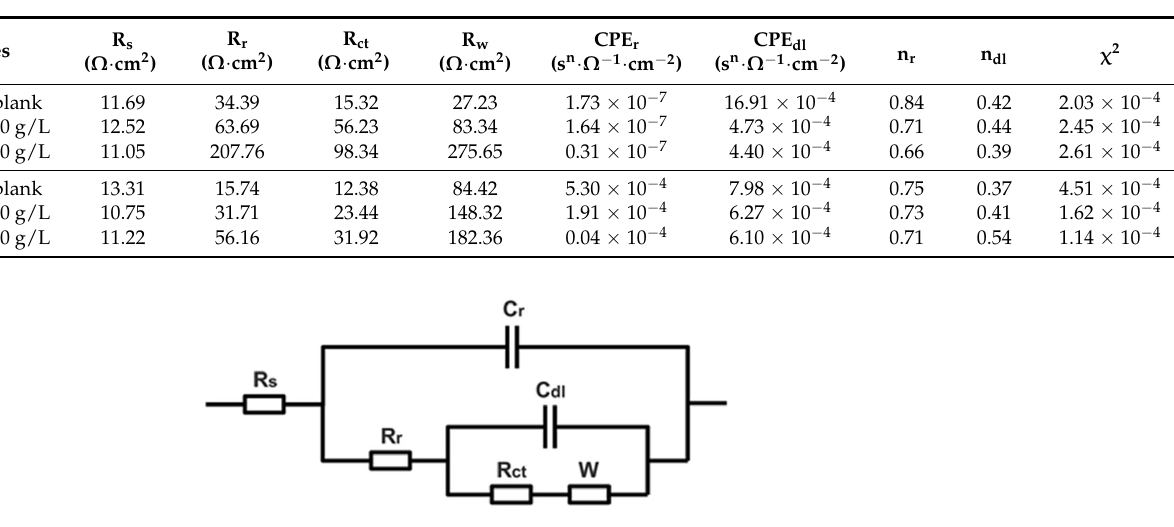
Figure 16. Equivalent circuits of EIS curves of archaeological steel. Table 1. Fitting parameters of EIS curves of archaeological steel.